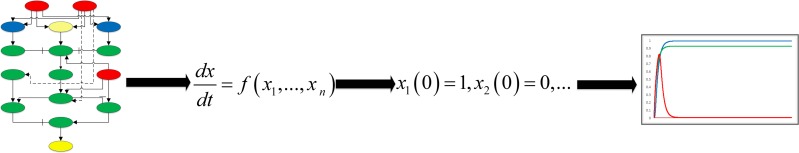
Schematic diagram of constructing a continuous dynamical system.